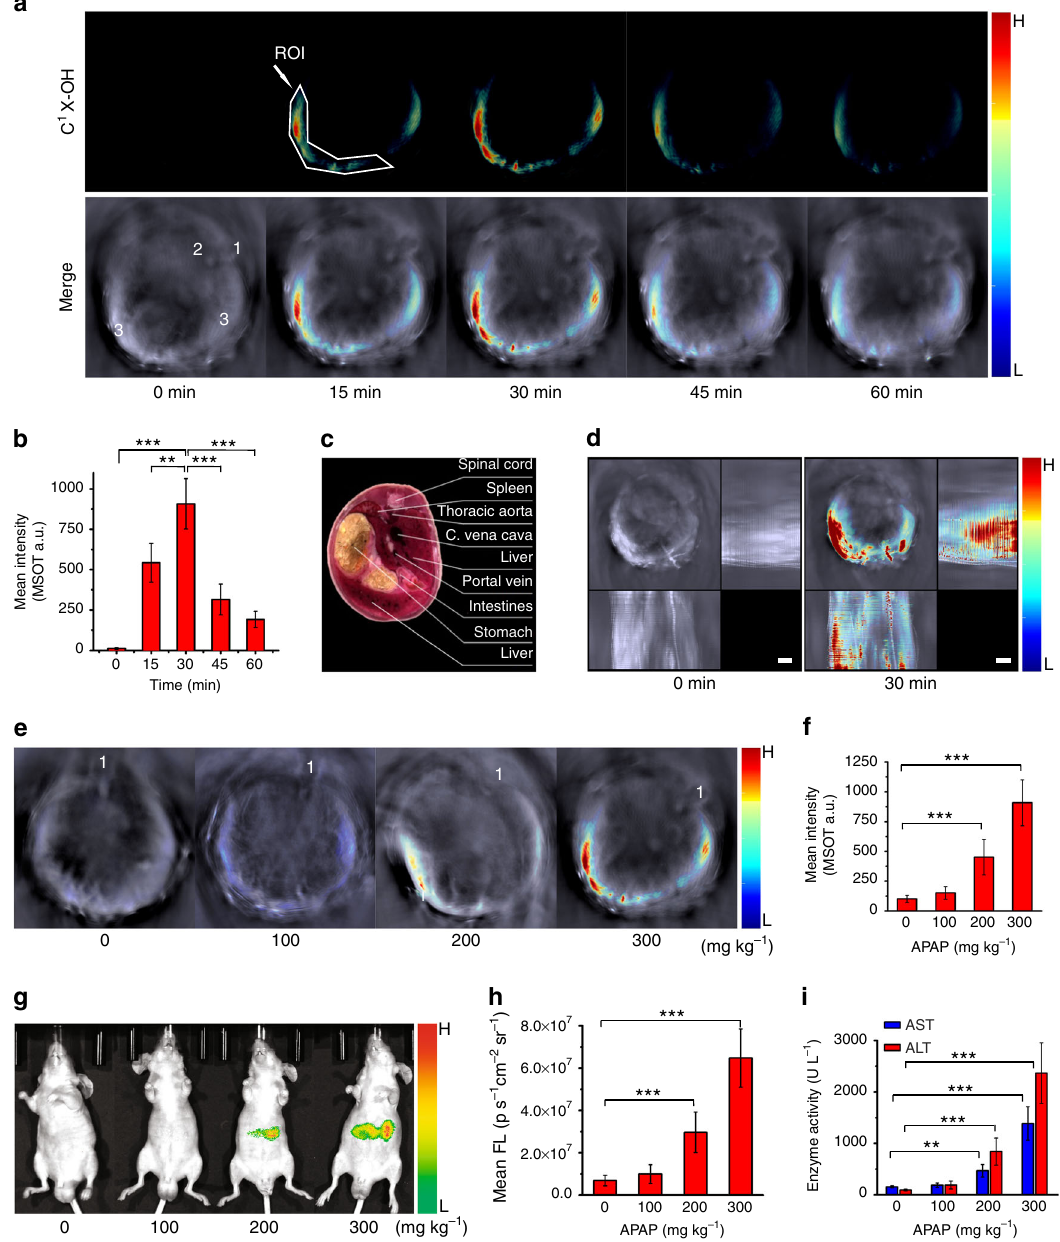
Fig. 3 Imaging drug-induced liver injury by using C 1 X-OR 1 . a Representative cross-sectional MSOT images of a mouse at varied time points upon injection of C 1 X-OR 1 . The mouse was pre-treated with 300 mg kg − 1 of APAP 12 h in advance. Upper panel: multispectral resolved signal for C 1 X-OH (activated probe). Lower panel: overlay of C 1 X-OH ’ s signal with the grayscale single-wavelength (800 nm) background image. Organ labeling: 1. spinal cord; 2. aorta; 3. liver. The position of spinal cord indicates the mouse lay on its chest with a certain tilt. b Mean optoacoustic intensities at ROI in liver area for the APAP- treated mice at varied time points upon liposomal C 1 X-OR 1 injection ( n = 6 per group). c A cryosection image of a male mouse with the cross section ’ s location comparable to those shown in a . d Representative z-stack orthogonal maximal intensity projection (MIP) images for the mice pretreated with 300 mg kg − 1 APAP before and 30 min after injection of the liposomal probe. e Typical cross-sectional MSOT images (with background) of the mice pretreated with varied dose of APAP at 30 min upon probe injection. The images for the probe without background are presented in Supplementary Figure 31a. The spinal cords were labeled with 1 to re fl ect the mice ’ s lying position in the chamber. f Mean optoacoustic intensities at ROI in liver area for the mice pretreated with varied dose of APAP ( n = 6 per group). g Representative fl uorescent images revealing biodistribution of the activated probe for the mice pretreated with varied dose of APAP and injected with the probe. The mice lay on their back during imaging, thus the distribution of fl uorescent signal looks different from that of MSOT. h Mean fl uorescent intensities at ROI of the mice pretreated with varied dose of APAP ( n = 9 per group). i Serum levels of AST and ALT for the mice at 12 h upon treatment with varied dose of APAP ( n = 9 per group). The net C 1 X-OR 1 dosage for all imaging is 3.7 mg kg − 1 . Columns represent means ± SD. The p -values (** p < 0.01, *** p < 0.001) were determined using two-sided Student ’ s t